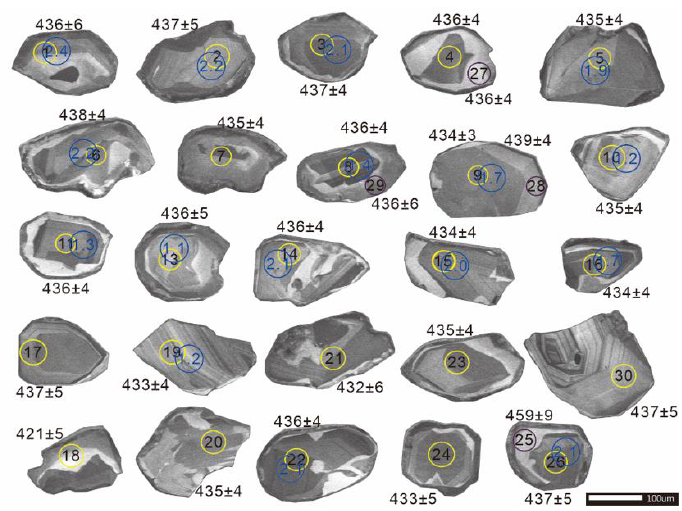
Figure 7. Zircon cathodoluminescence (CL) images of Yuejingshan gabbro. Yellow circles and black numbers represent U–Pb test spots and ages. Blue circles and numbers represent Lu–Hf tested spots and related εHf (t) values.